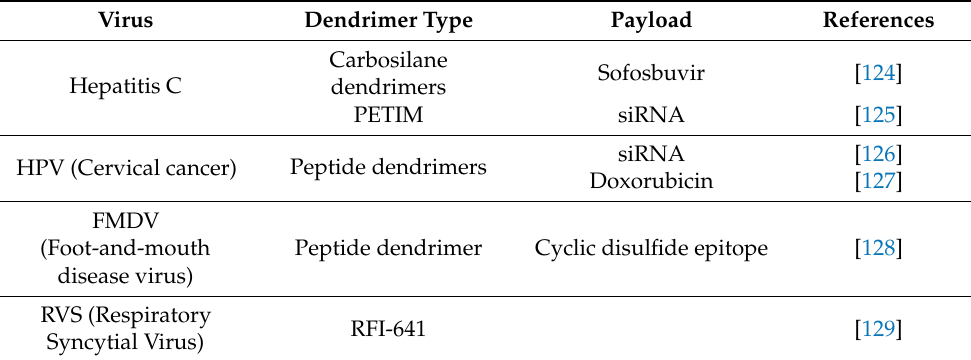
Table 2. Antiviral application of